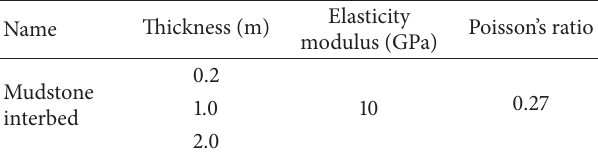
Table 3: No. 1 simulation scheme.